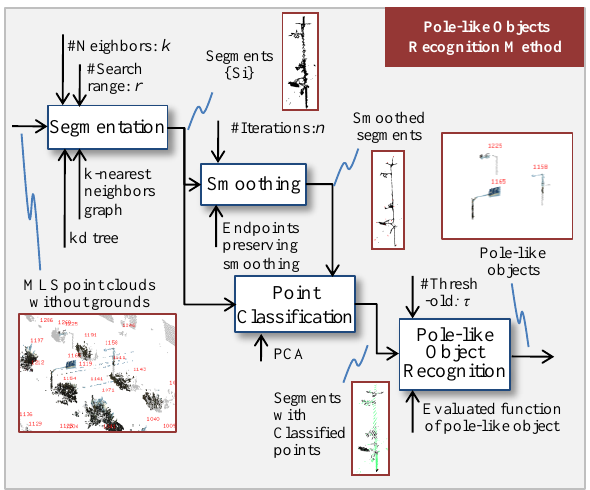
Figure 1. Proposed algorithm of pole-like objects recognition